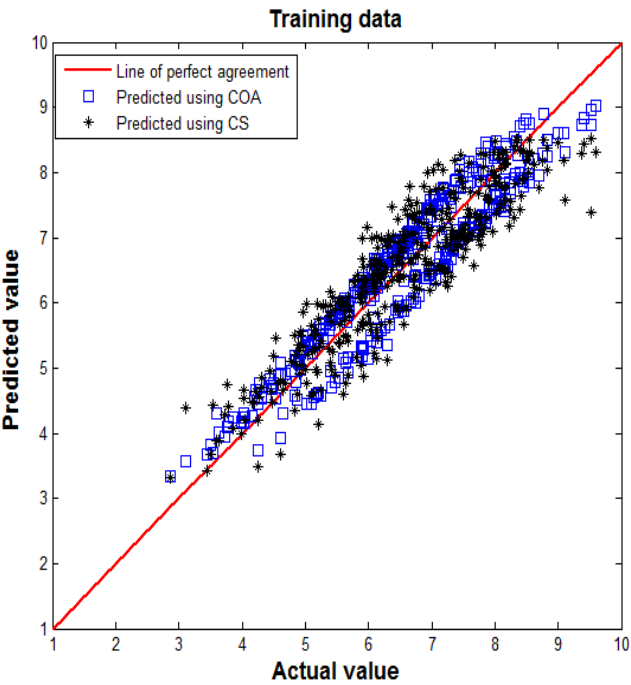
Figure 6. Comparison between actual and predicted values in training